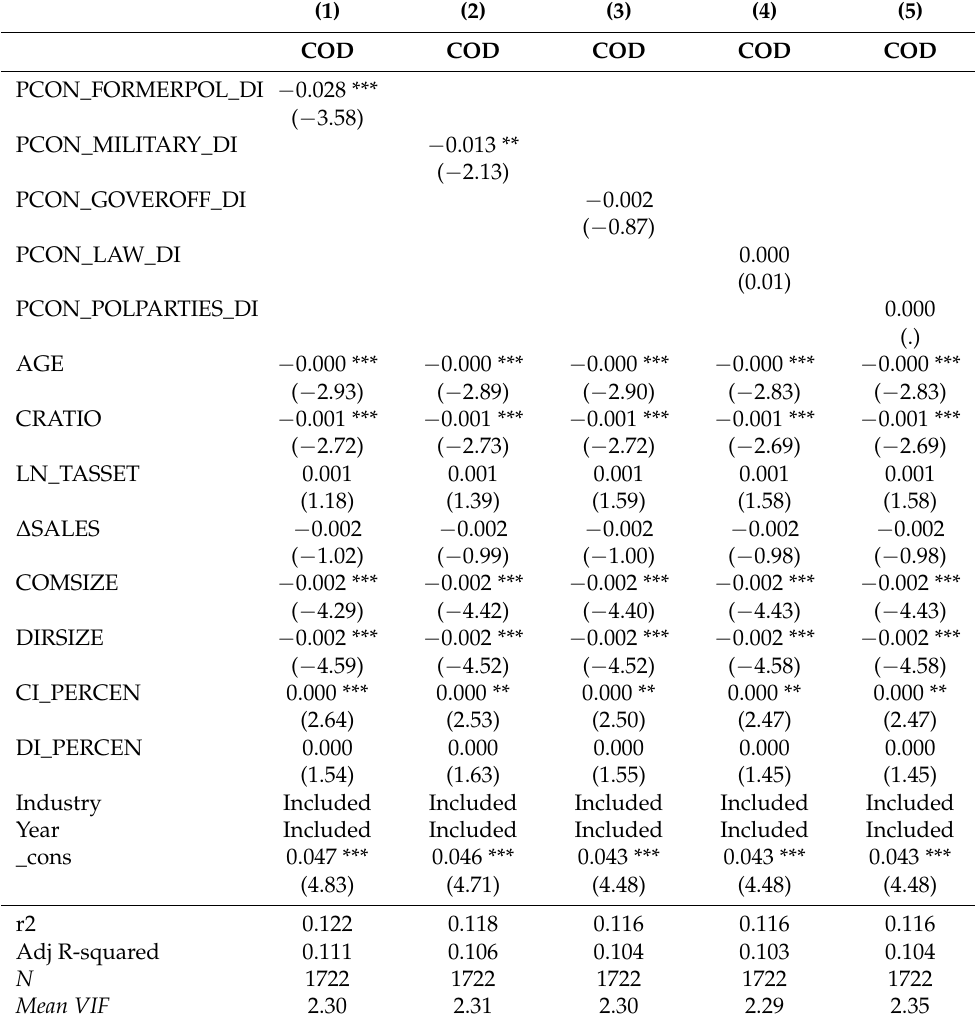
Table 13. Regression of 5 types of independent directors’ political connection to the cost of